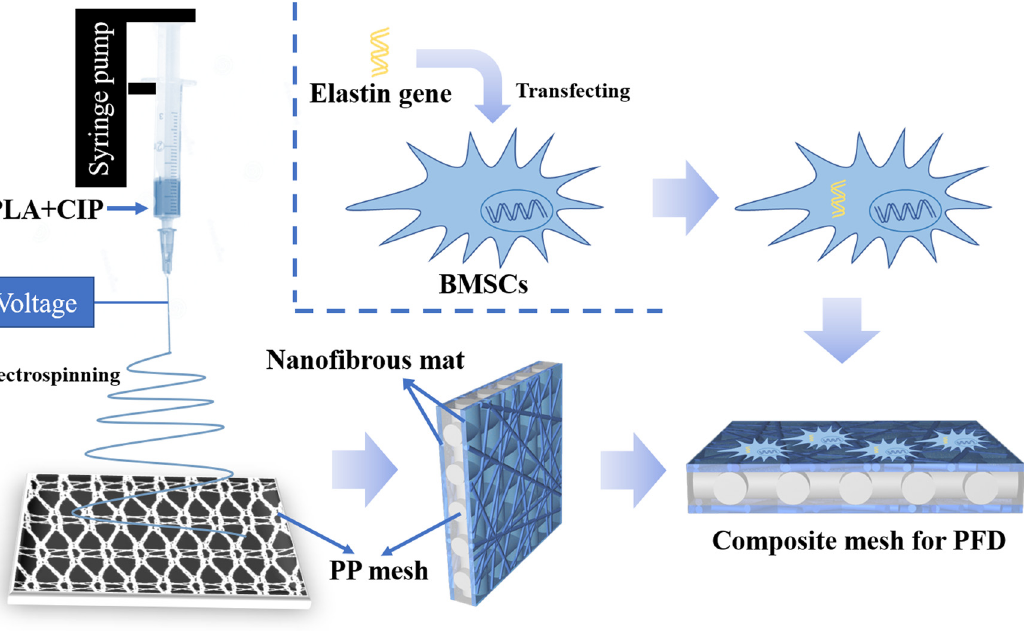
Figure 1: Schematic strategy of composite PP mesh incorporated with elastin gene - transfected BMSCs and CIP - loaded PLA nano fi brous mat coating for the PFD